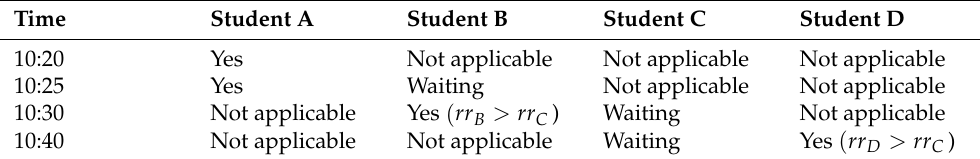
Figure 1. The visualization of 𝑔(𝑝) and 𝑓(𝑤) . Table 2. The statues of requests. “Not applicable” means that someone has not arrived or left. “Yes” means a person has entered the canteen with permission already. “Waiting” indicates that a student’s request cannot be immediately satisfied. Note that not every moment is